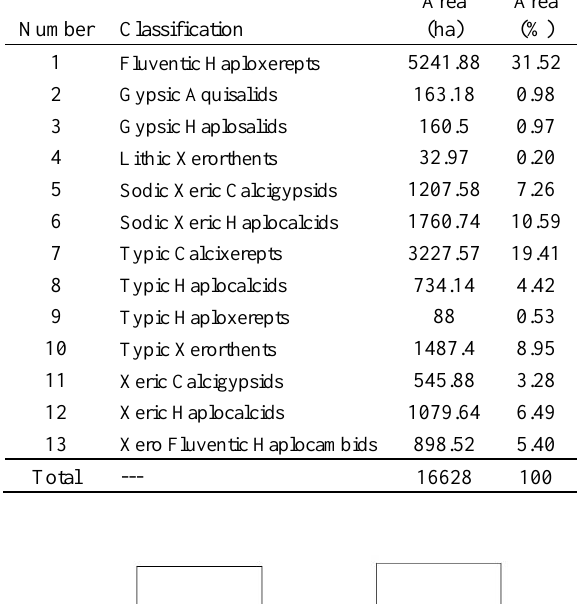
Table 2: Soil subgroup class